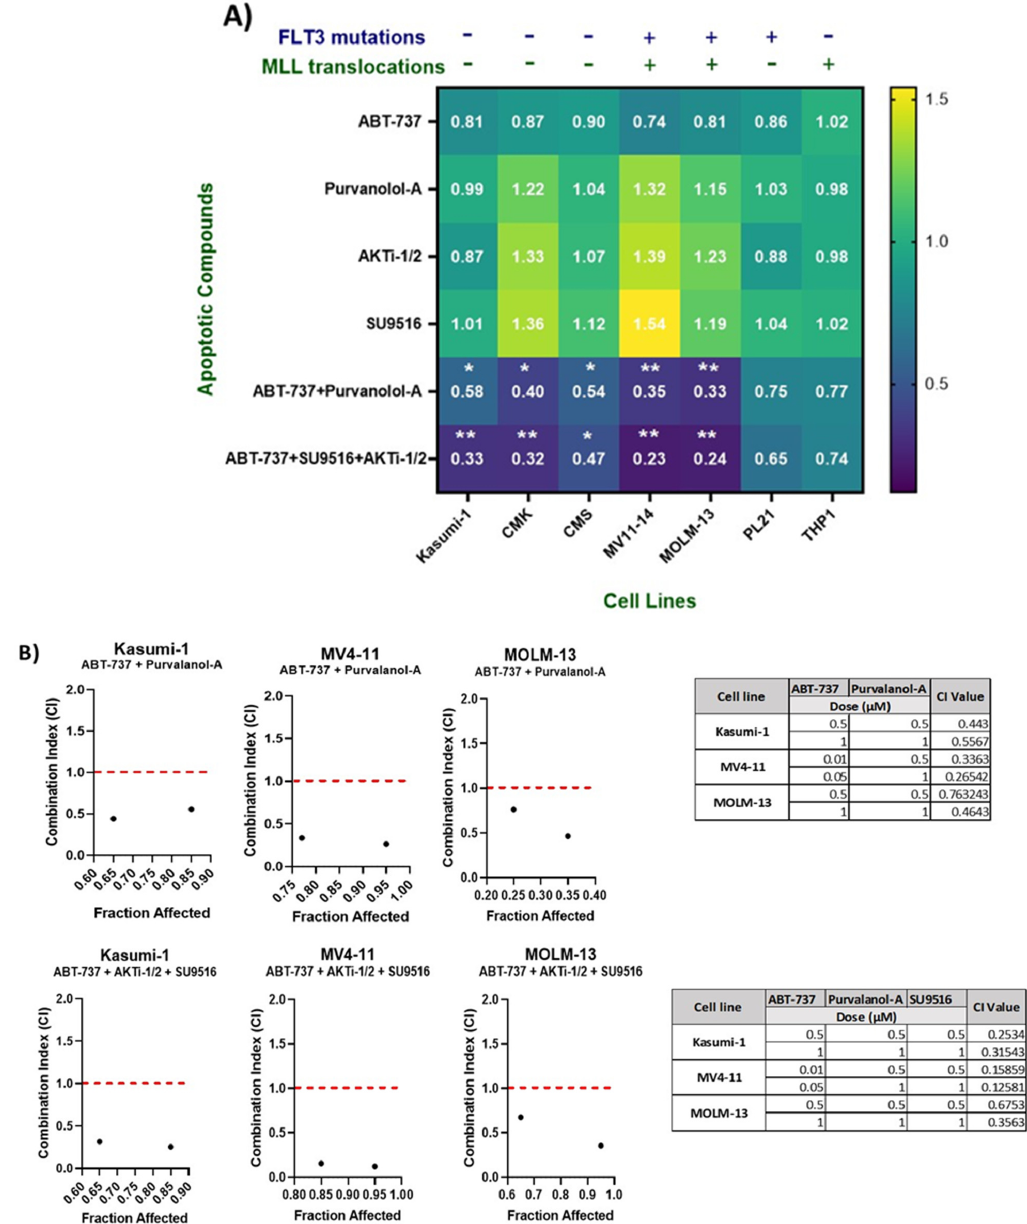
Figure 2. ( A ) Validation of combination treatments using CellTiter ® Glo, which measures ATP, which is proportional to cell viability after 72 h. Luminescence was measured using a Synergy HTX Multi ‐ Mode Microplate reader. Values were normalised to DMSO controls. Data are representative of N = 3 ± SEM. ( B ) Optimisation of the best dose for the maximum synergistic effect of successful combinations using combination index (CI) values. Combination index values were determined for ABT-737 + Purvalanol-A and ABT-737 + AKTi-1/2 + SU9516 in Kasumi-1, MV4-11, and MOLM-13 cell lines. CI > 1 is antagonistic, CI = 1 is additive, and CI < 1 is synergistic. This combination demonstrated synergism at multiple concentrations across both cell lines. Data are representative of N = 3 ± SEM. * = p < 0.05, ** = p <